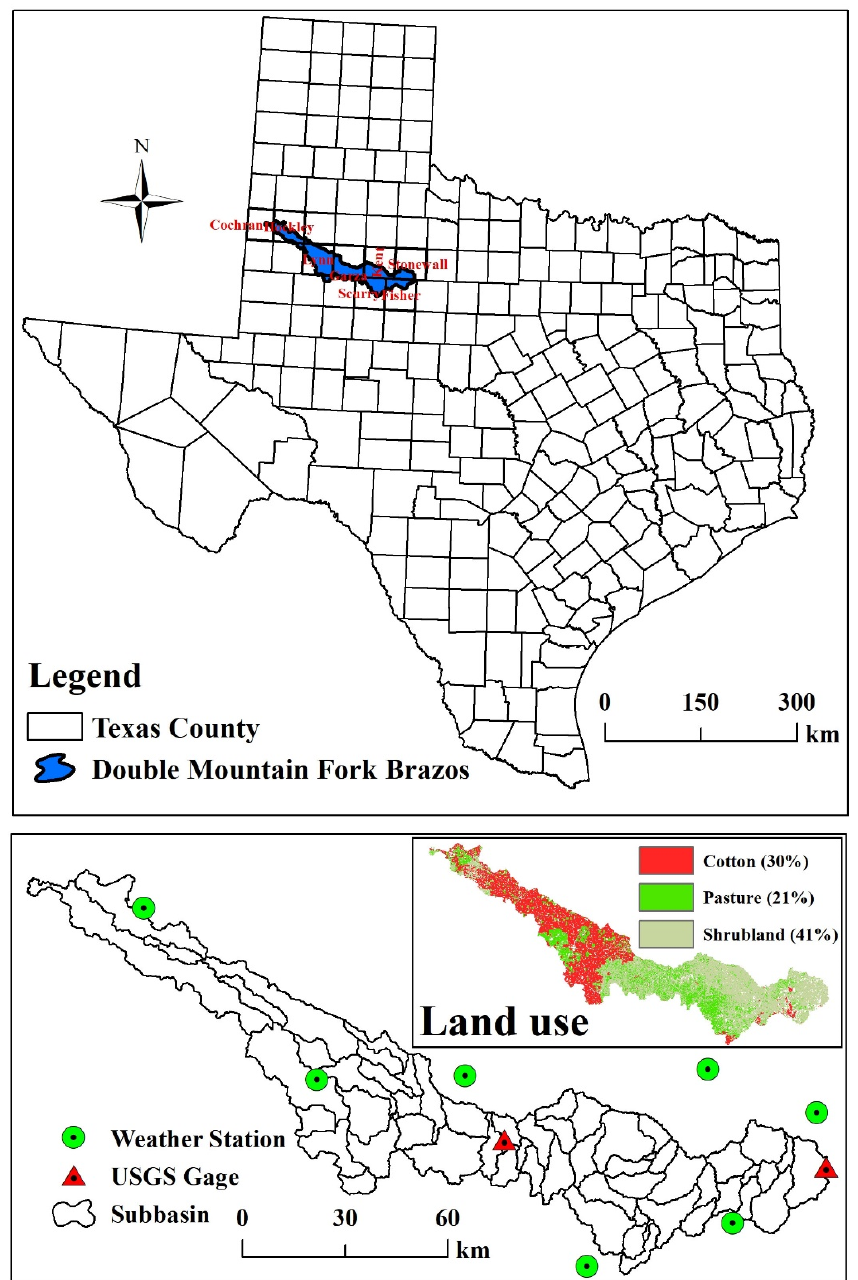
Figure 1. Location, land uses, weather stations, and stream gaging stations of the Double Mountain Fork Brazos